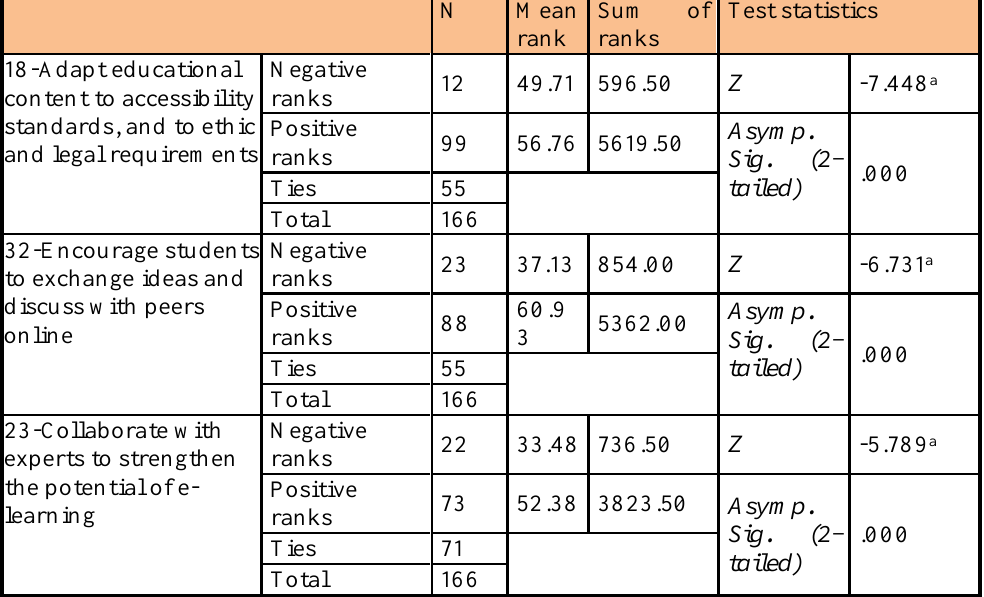
Wilcoxon Signed Ranks Test. Median Difference on the Level of Proficiency and Professional Development Needs Regarding the Personal Role Competencies Applied to Online